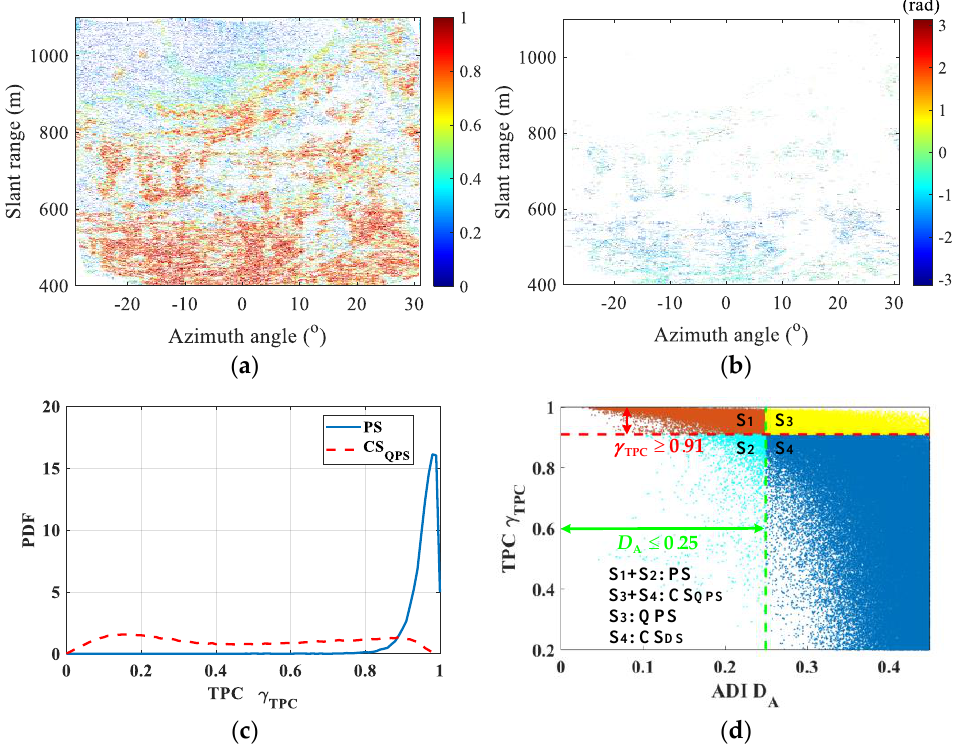
Figure 13. ( a ) TPC map of the CS QPS ; ( b ) phase map of the QPSs (quasi-permanent scatterers) selected with the threshold of γ T = 0.91. ( c ) Probability density curves of γ TPC of the reference PSs and CS QPS ; and ( d ) scatter map of γ TPC with D A for the PSs and CS QPS . After the QPS selection, the remaining pixels are belonging to the set CS DS . For every pixel, it is used as the center of a 5 × 7 rectangular window, where 5 is the pixel number along the azimuth direction, and 7 is along the range number. The statistically homogeneous pixel of every pixel is determined based on the two-sample KS test. Figure 14a shows the homogeneous pixel map of CS DS . By setting a number threshold of N T = 10, 111,406 DSs could be selected. Based on (7)–(9), γ DS of these DSs are calculated and shown in Figure 14b. With the coherence threshold γ T = 0.91, 4260 DSs are reserved. Although the DS number is only 16.7% of the PS number, it still benefits increasing the pixel number utilized for differential interferometry. Figure 14c shows the phase map of the selected DSs, which sparsely distribute on the map. Above all, a total of 50,199 HQPs are selected, including 25,575 PSs, 20,364 QPSs, and 4260 DSs. Figure 14d shows the phase map of the HQPs. Contrast with the PSs selected only with the ADI criterion, the HQPs increase by 96.3%. The spatial density of the pixels for deformation analysis has been significantly increased. Other than the increase in the HQP number, analysis on the phase quality should be further